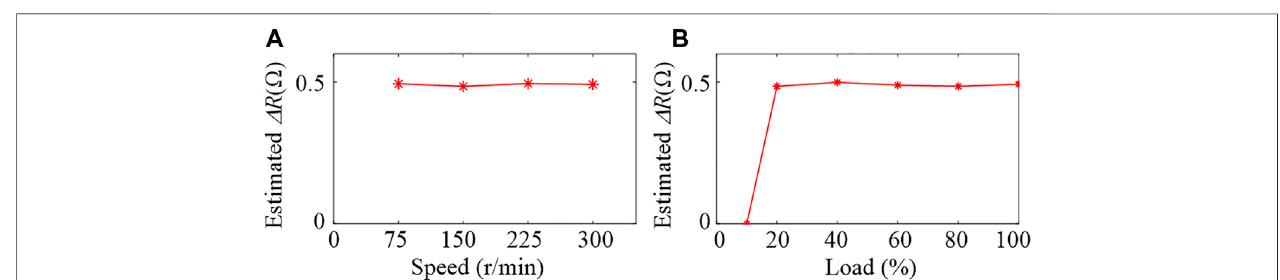
Frontiers in Energy Research |